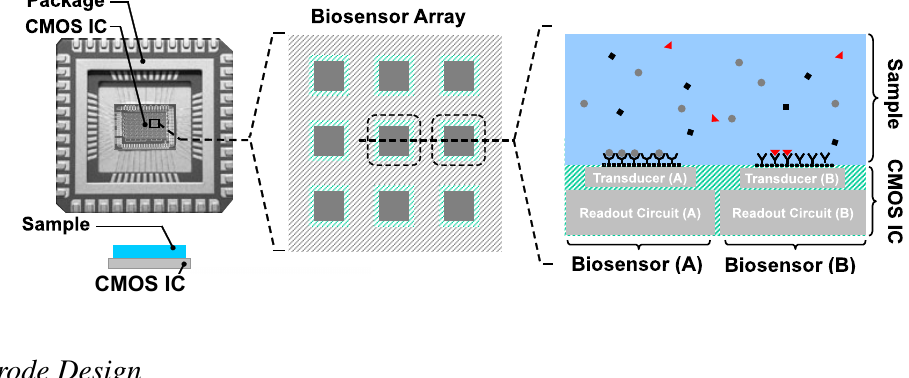
Figure 3. Anatomy of an integrated biosensor.